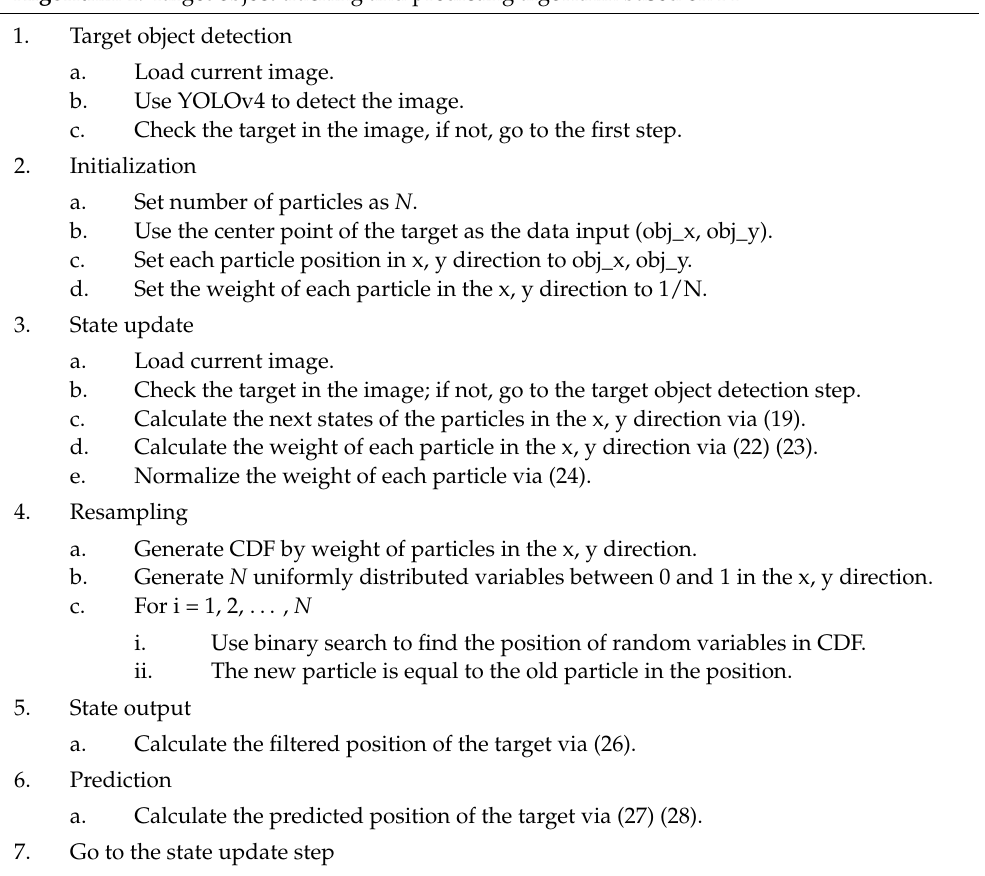
Algorithm 1. Target object tracking and predicting algorithm based on